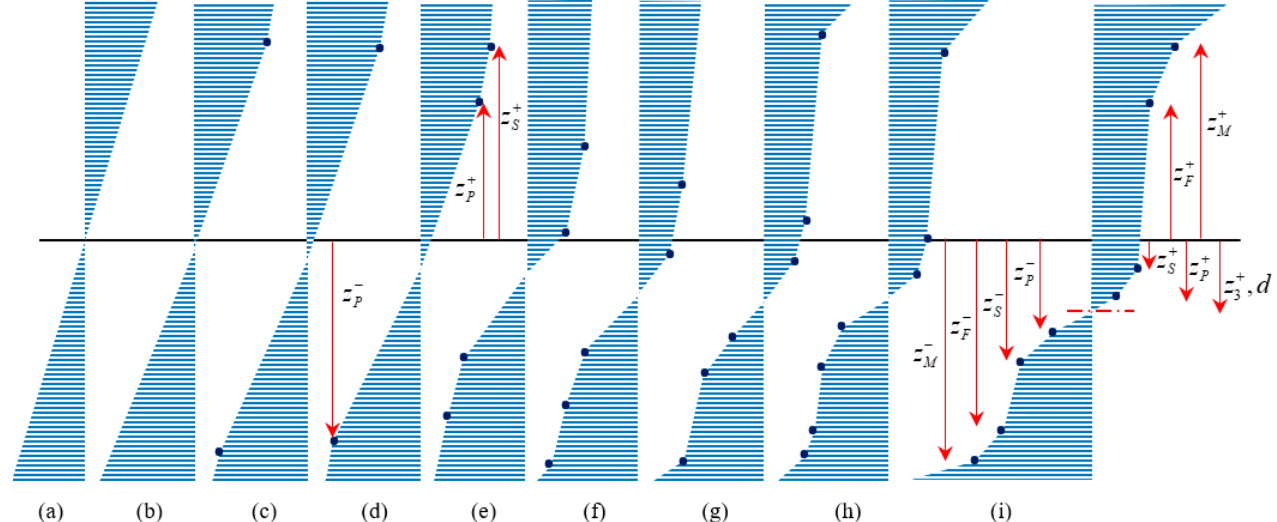
Figure 3. Normal stress–height diagram during different phases of loading, fibers are located in ( a ) elastic zone, ( b ) T1- zone favored by tension, ( c ) T1-zone favored by compression, ( d ) VR-zone favored by tension, ( e ) VR-zone favored by compression, ( f ) T2-zone favored by compression, ( g ) T2-zone favored by tension, ( h ) D-zone favored by compression, ( i ) D-zone favored by tension.